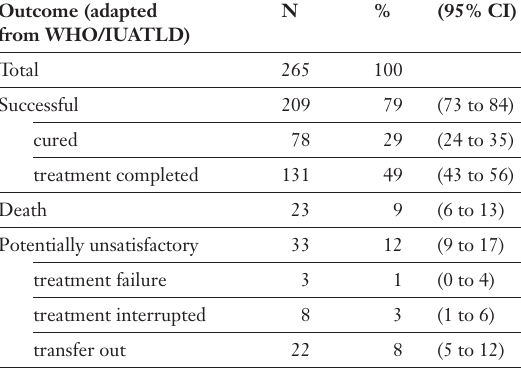
Treatment outcome at 6 months after the start of antituber- culosis treatment.